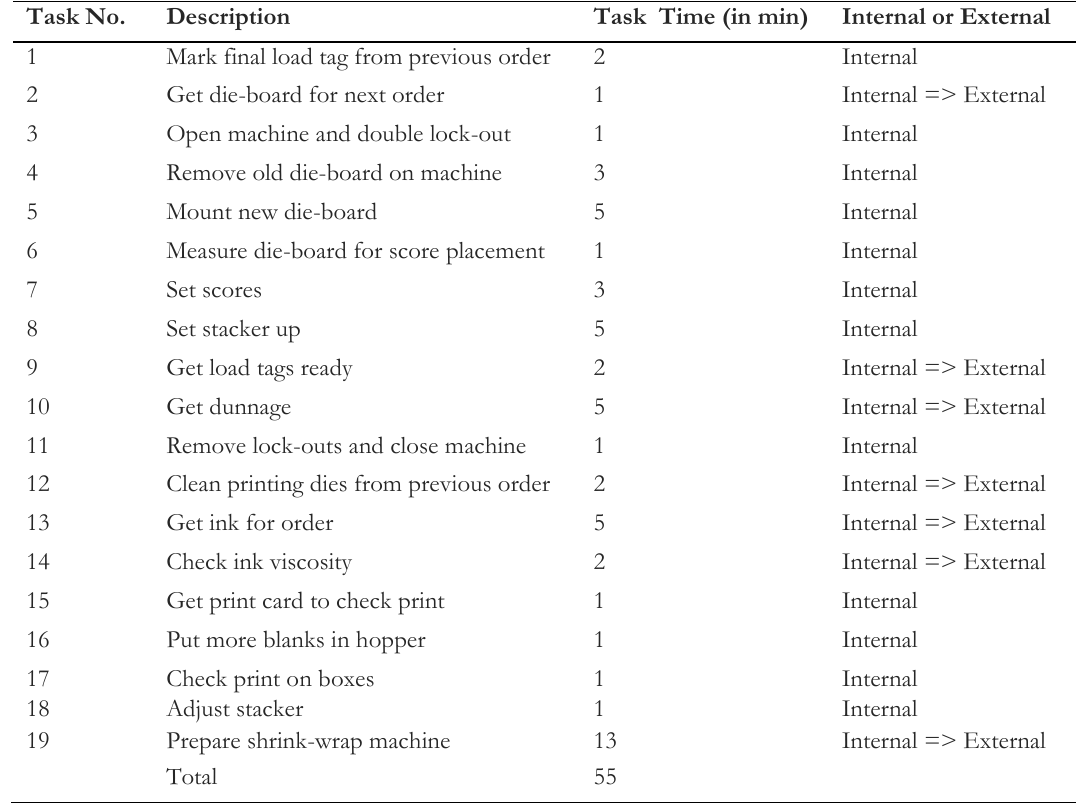
Table 2. Check sheet for identifying setup tasks by setup